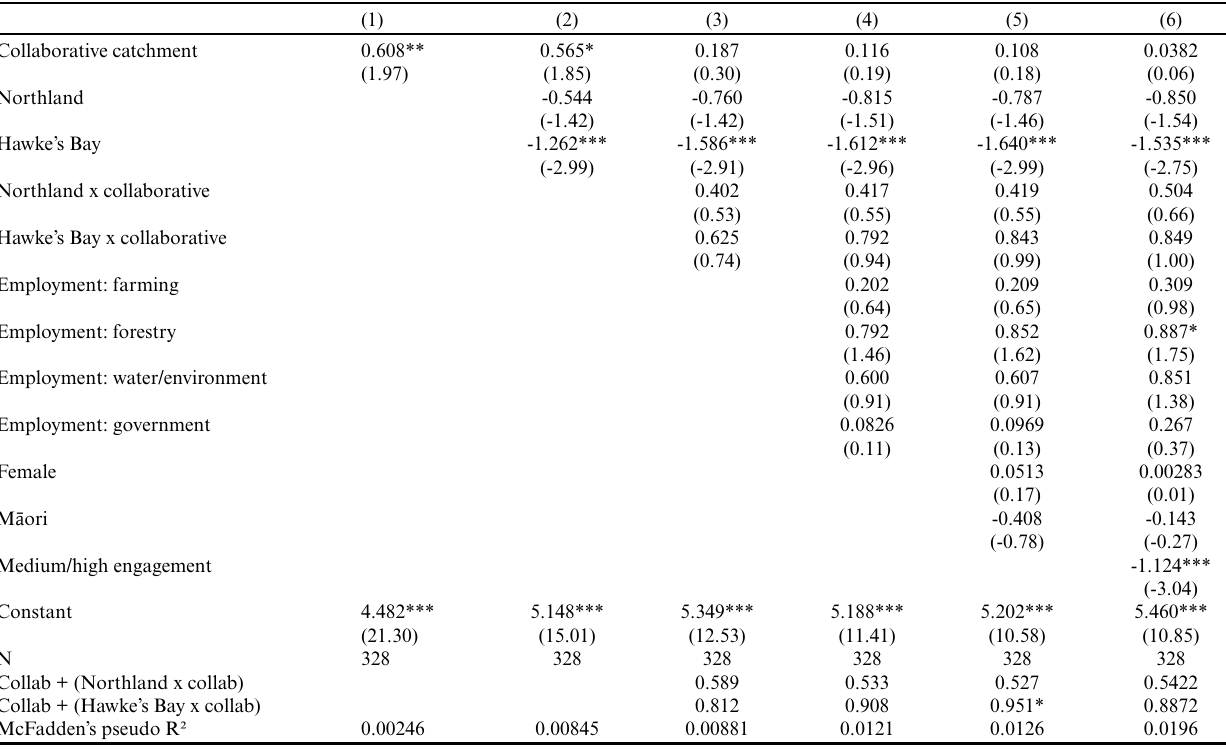
Table 3 . Perceptions of agreement on management of freshwater resources (“Thinking about conflict or agreement between competing interests over water management in your area, using a scale of 0 to 10 where 0 means lots of conflict and 10 means strong agreement, would you say there is conflict or agreement between competing interests over water management in your